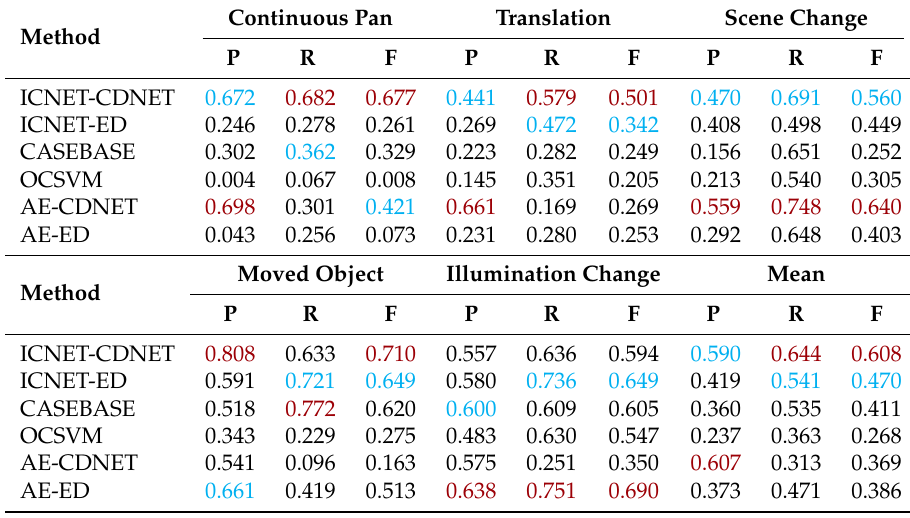
Table 4. Detection accuracy in terms of precision (P), recall (R), and F-measure (F) based on the best parameters for the F-measure. The red and blue numbers denote the best and second-best score in each sequence,